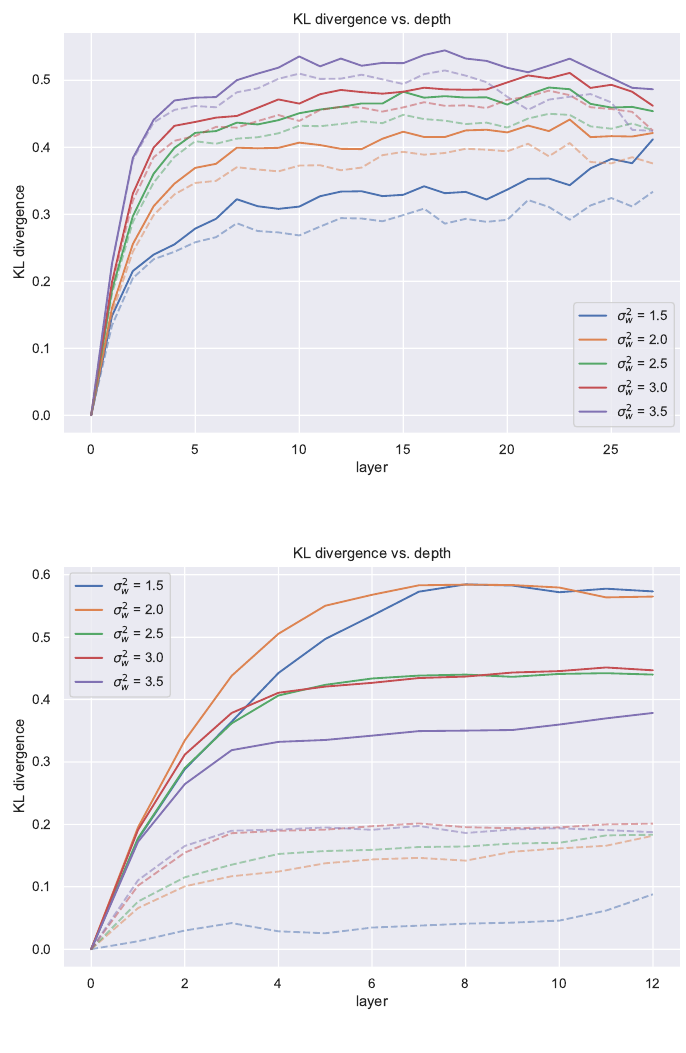
Figure 7: Plot of the KL divergence (83) before (dashed) and after (solid) training for = 0.05, for which the critical networks with varying initializations σ 2 and fixed σ 2 w b ≈ 1.76. Results for MNIST (top) and CIFAR-10 (bottom) are point corresponds to σ 2 w shown for networks with a fixed depth of 30 and 15 layers, respectively. The essen- tial qualitative features – namely a sharp increase to an asymptote – are preserved through training and across different